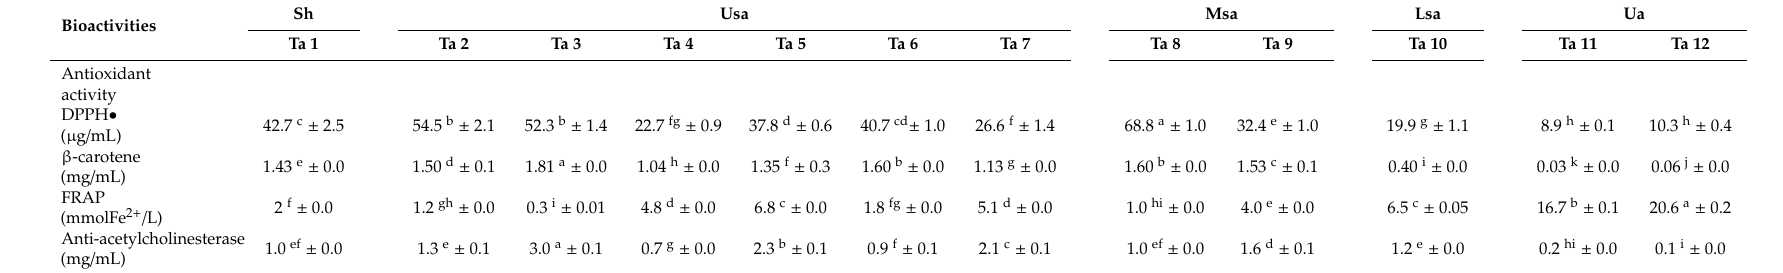
Table 5. Antioxidant and anti-acetylcholinesterase activities of T. algeriensis methanolic